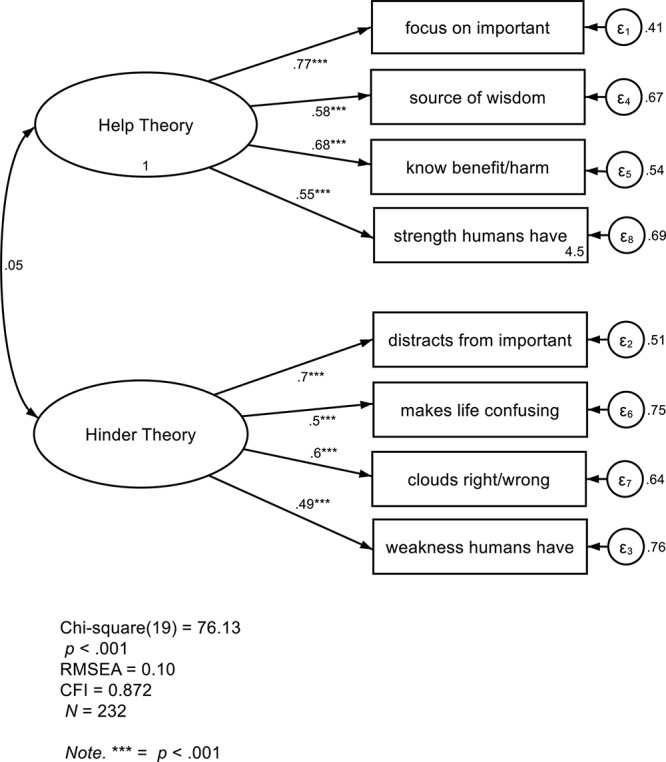
Study 1 confirmatory factor analysis with the distinct Help Theory and Hinder Theory factors, with standardized regression coefficients displayed.